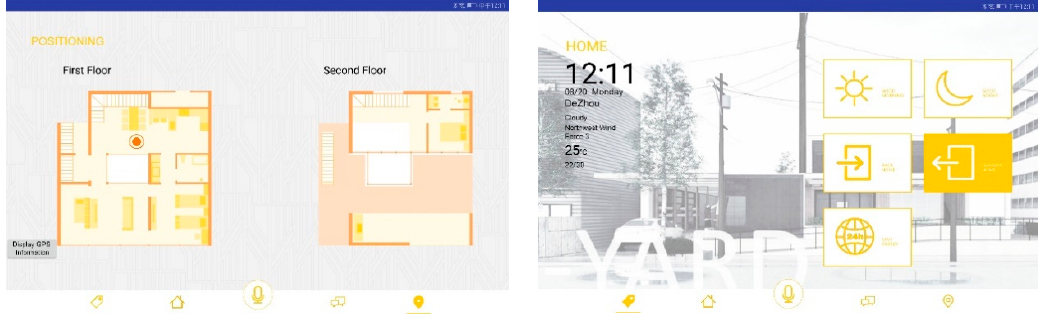
Figure 15. Intelligent app control and monitoring system.